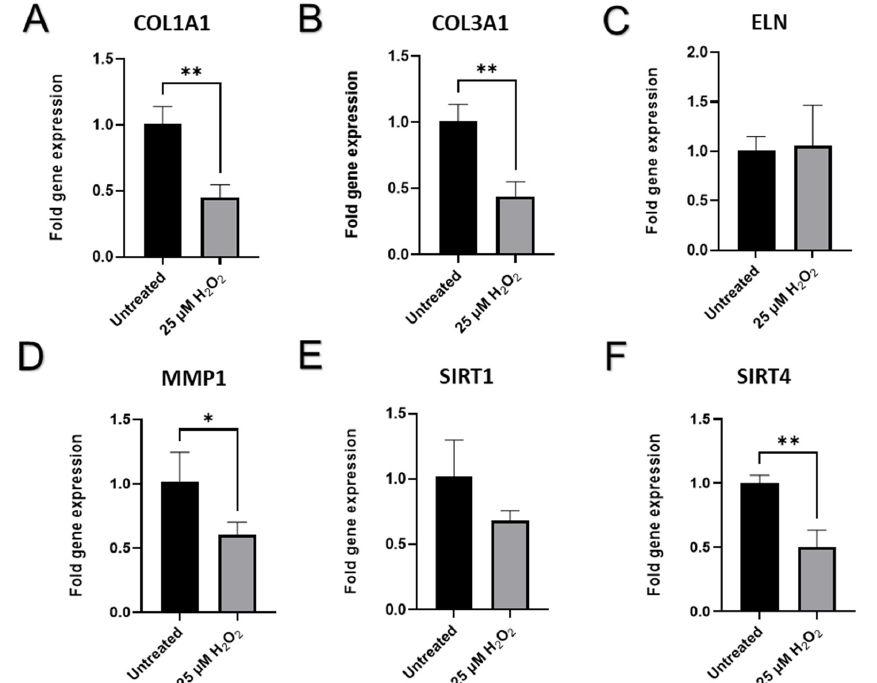
Figure 8. The effects of age on mRNA production of extracellular matrix components and functional regulators in BJ-5ta (p.24) fibroblasts. Changes of mRNA expression as measured by RT-qPCR for ( A ) COL1A1 ; ( B ) COL3A1 ; ( C ) ELN; ( D ) MMP-1 ; ( E ), SIRT-1 ; ( F ) SIRT-4 . Data were with an unpaired Student’s t -test. Significance (p) is indicated within the figures using the following scale: *, p < 0.05; **, p < 0.01. Bars represent mean ± SD. Additional non-significant mRNA expression of genes can be seen in Figure